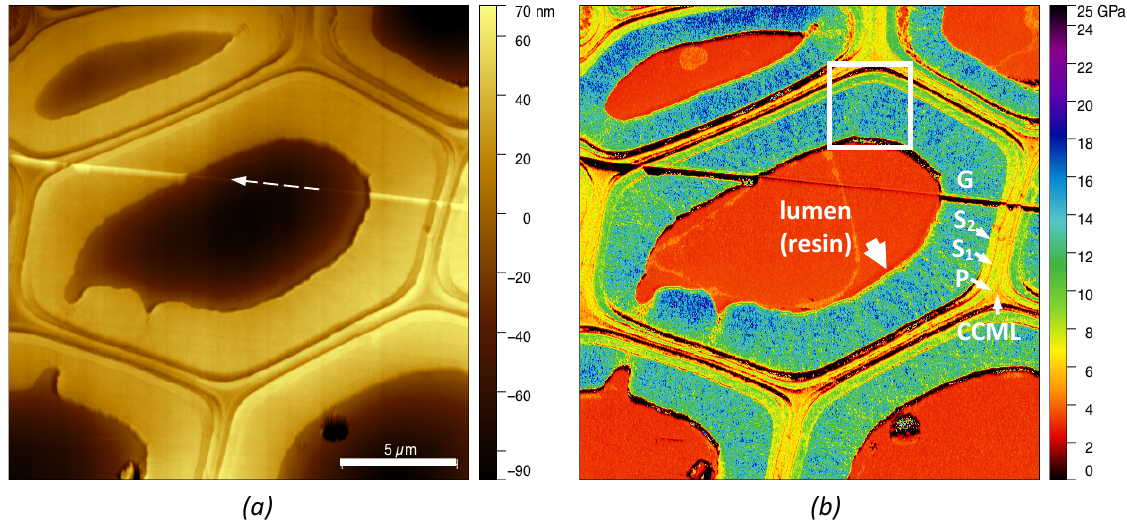
Figure 2 : PF-QNM mapping of (a) topography and (b) indentation modulus of the cross section of a tension wood fibre at 740 µm from the cambium (first radial row). The different layers are identified: P stands for primary wall and CCML for cell corner middle lamella. The lumen of the cell was filled with LR-White resin. The white dashed arrow in (a) shows the microtome cutting direction (following a scratch line due to imperfections of the diamond knife), the thick white arrow in (b) points to a thin softer sub-layer that is more visible in Fig. 4, which is an enlargement of the white upper box in